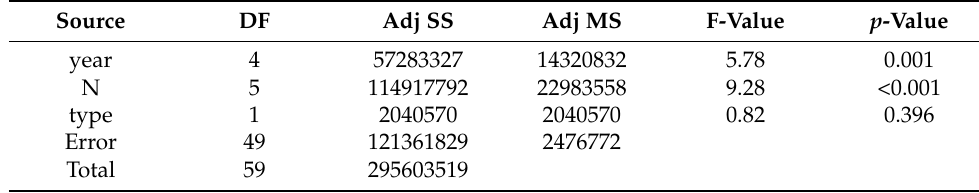
Table 9. Component variance analysis on parameters.